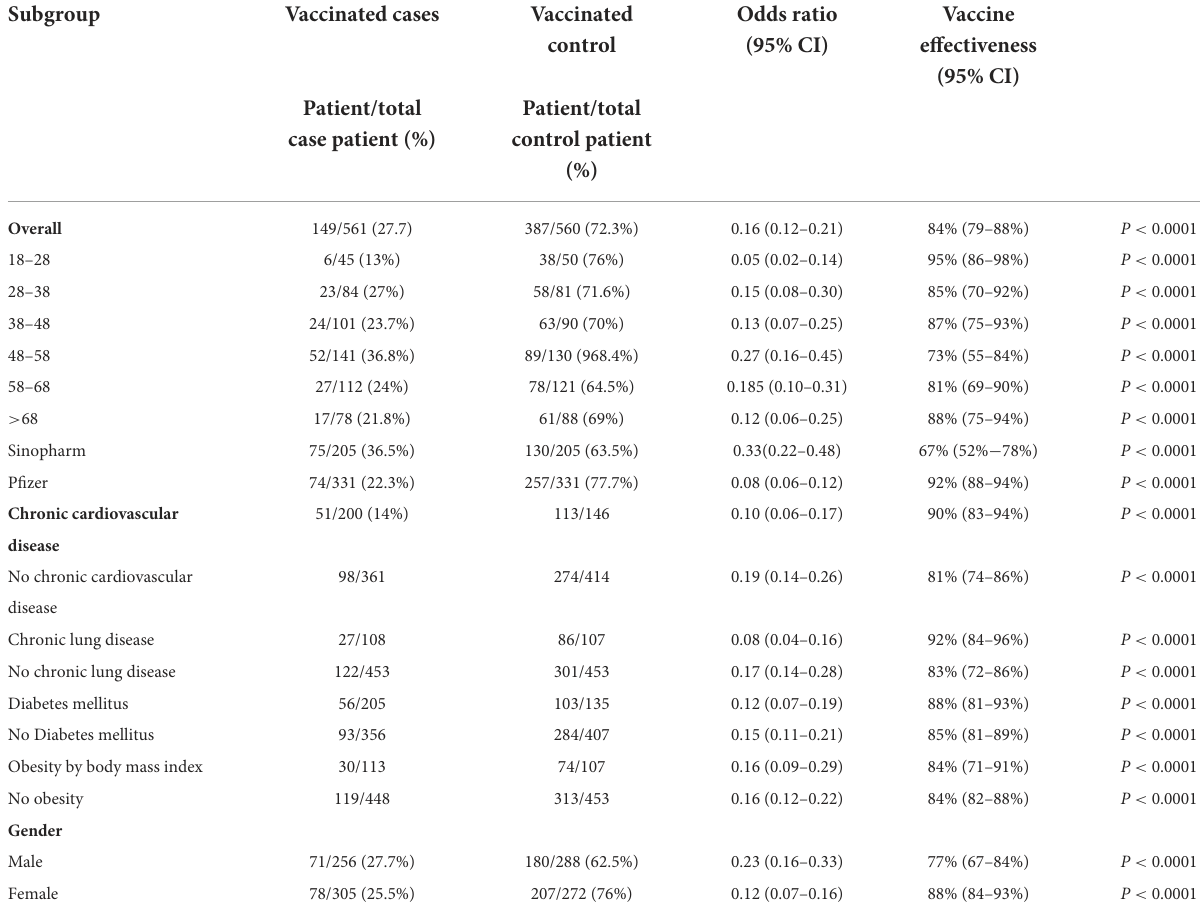
TABLE 2 Vaccine effectiveness of Pfizer-BioNTech and Sinopharm vaccines against COVID-19 hospitalization overall and by subgroup.